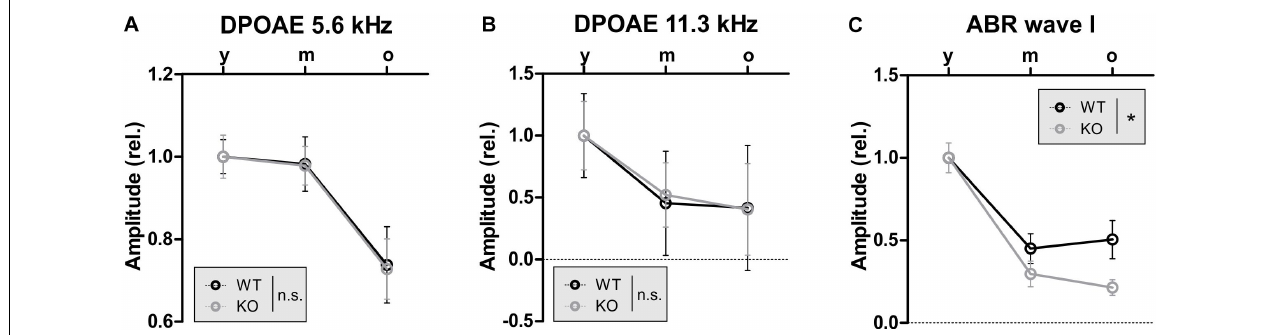
FIGURE 8 | GC-A KO exhibit the same aging progress in OHC function as GC-A WT but accelerated reduction of auditory nerve responses over age. (A,B) DPOAE signal growth function in response to pure-tone sounds at f1 = 5.6 and 11.3 kHz were similarly reduced over age in GC-A KO and WT mice [5 kHz: two-way ANOVA, F (1,106) = 0.01, P = 0.928, n = 8–14/16–28 mice/ears each, 11 kHz: two-way ANOVA, F (1,106) = 0.00, P = 0.951, n = 8–14/16–28 mice/ears each]. (C) Noise-burst-evoked ABR wave I amplitude growth functions were more strongly reduced over age in GC-A KO than in WT mice [two-way ANOVA, F (1,71) = 4.72, P = 0.0033, n = 5–8/10–16 mice/ears each]. Mean ± SEM. ∗ P <